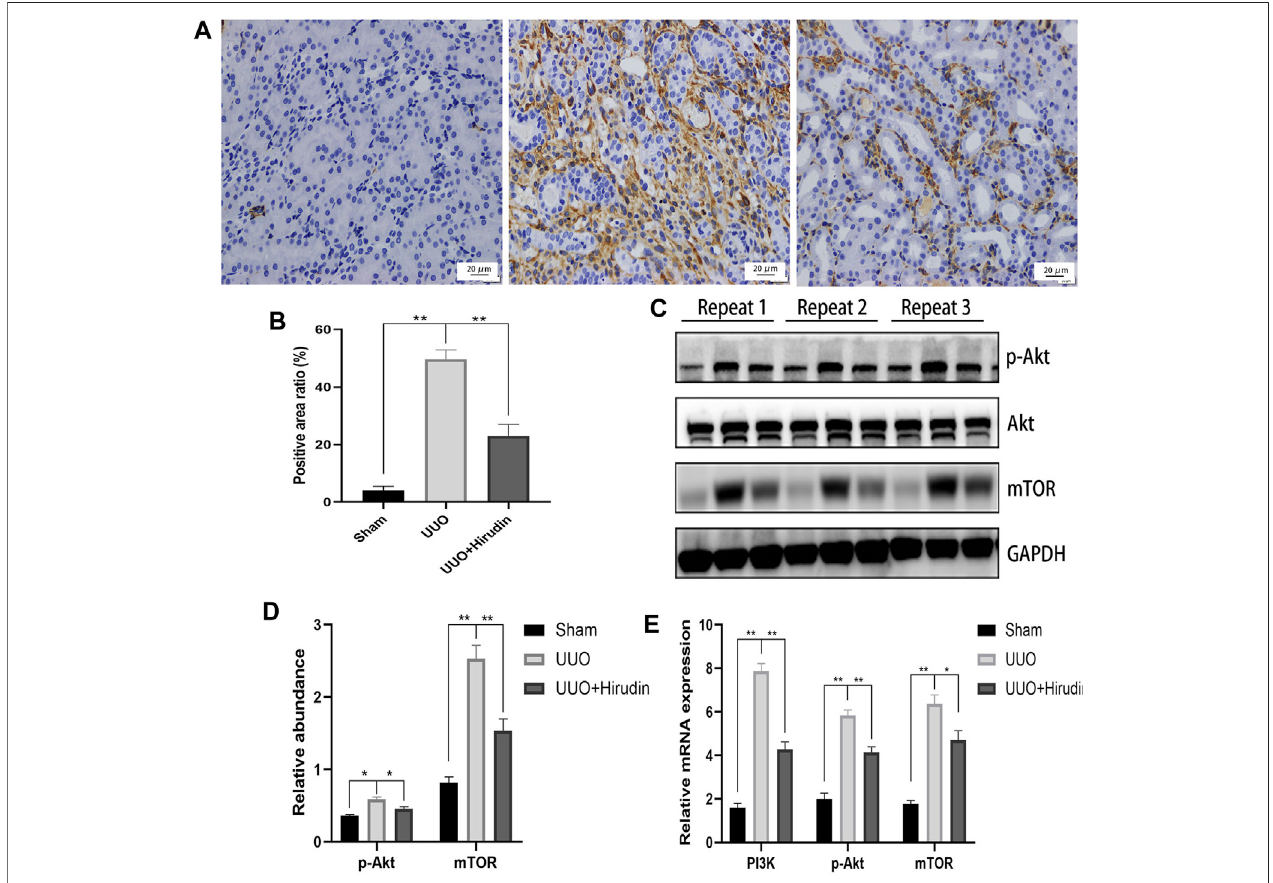
FIGURE 5 | Hirudin inhibited the PI3K/Akt signaling pathway in UUO kidneys. (A) Effect of hirudin on PI3K in UUO kidney tissues, as determined by immunohistochemical staining. (magni fi cation × 400) (B) Hirudin reduced the PI3K positive expression area in UUO kidneys, according to the results of immunohistochemicalstaining. (C) Effect ofhirudin onp-Aktand mTOR in UUO kidney tissues, asdetermined byWesternblot. (D) Effectofhirudin on p-Akt and mTOR inUUOkidneytissues,accordingtotheresultsofWesternblot. (E) EffectofhirudinonPI3K,p-AktandmTORinUUOkidneytissues,accordingtotheresultsofRT- qPCR. Data are expressed as mean ± SD for six rats per group. pp indicates p < 0.01and p indicates p <